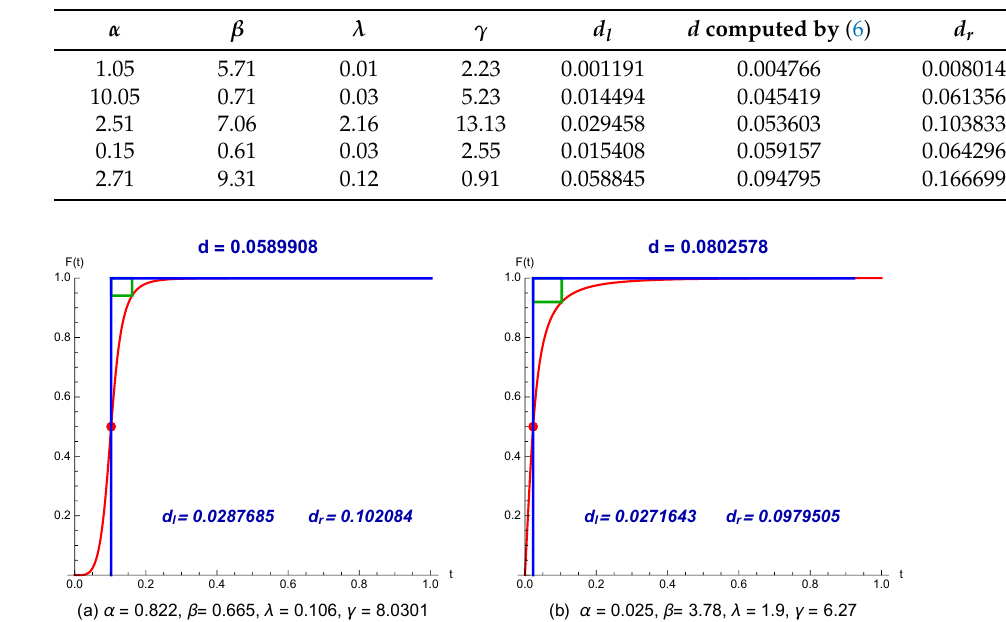
Table 1. Bounds for Hausdorff distance d according to Theorem 2.